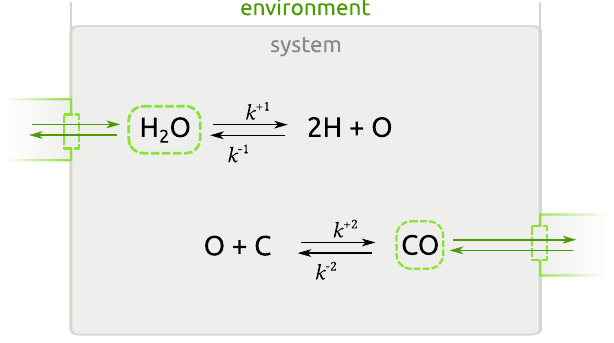
FIG. 3. Specific implementation of the CRN in Fig.